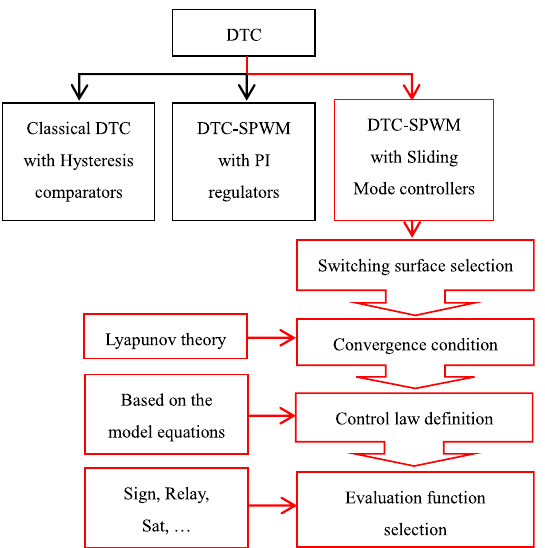
Fig. 2 Flowchart of the SM-DTC algorithm